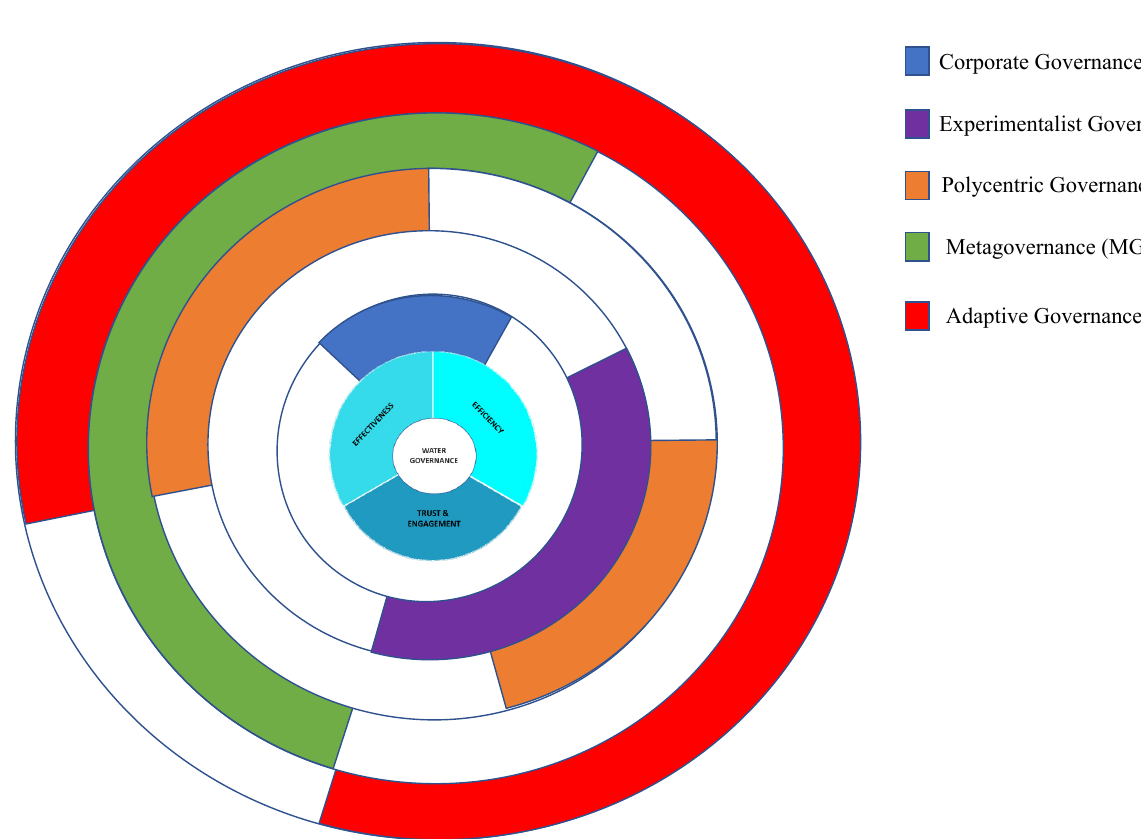
Figure 1. Water governance has different approaches on three dimensions proposed by the OECD, which can be adequately integrated if they are combined to overcome the challenges of its exclusive application. Source: Adapted from the OECD